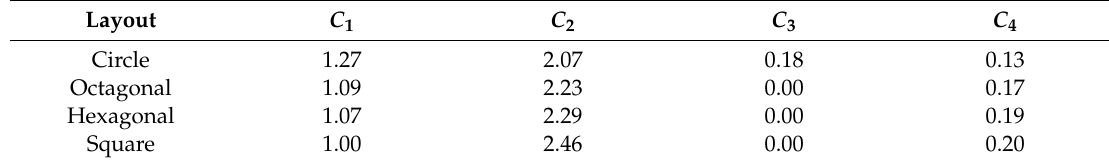
Table 1. Current sheet expression coefficients.